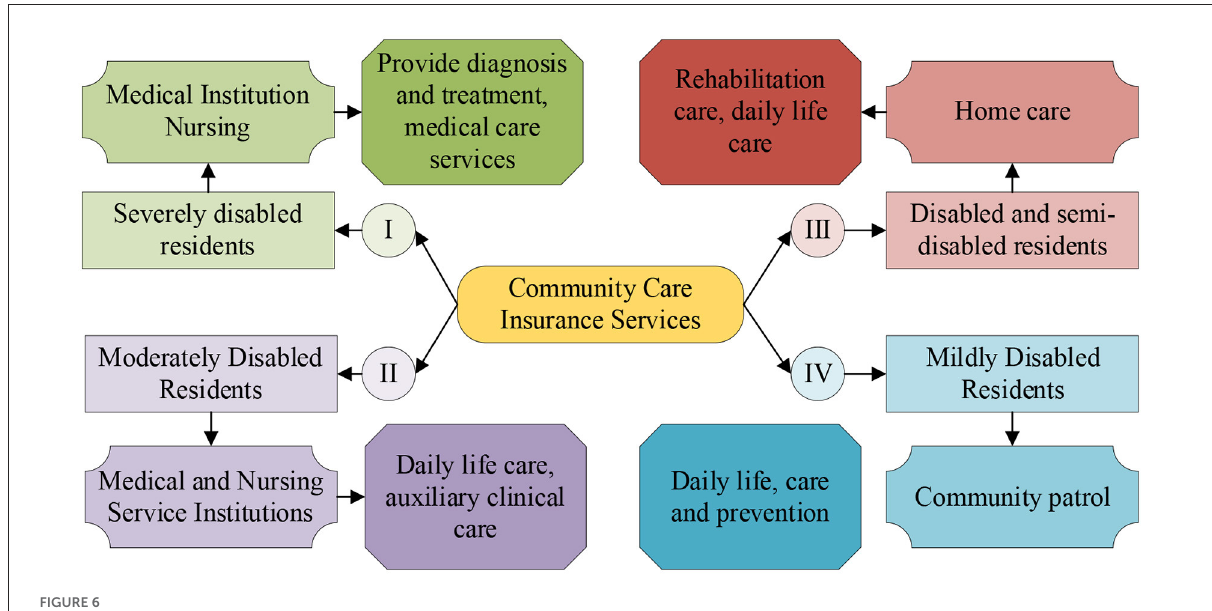
FIGURE6 Optimal design of community nursing insurance